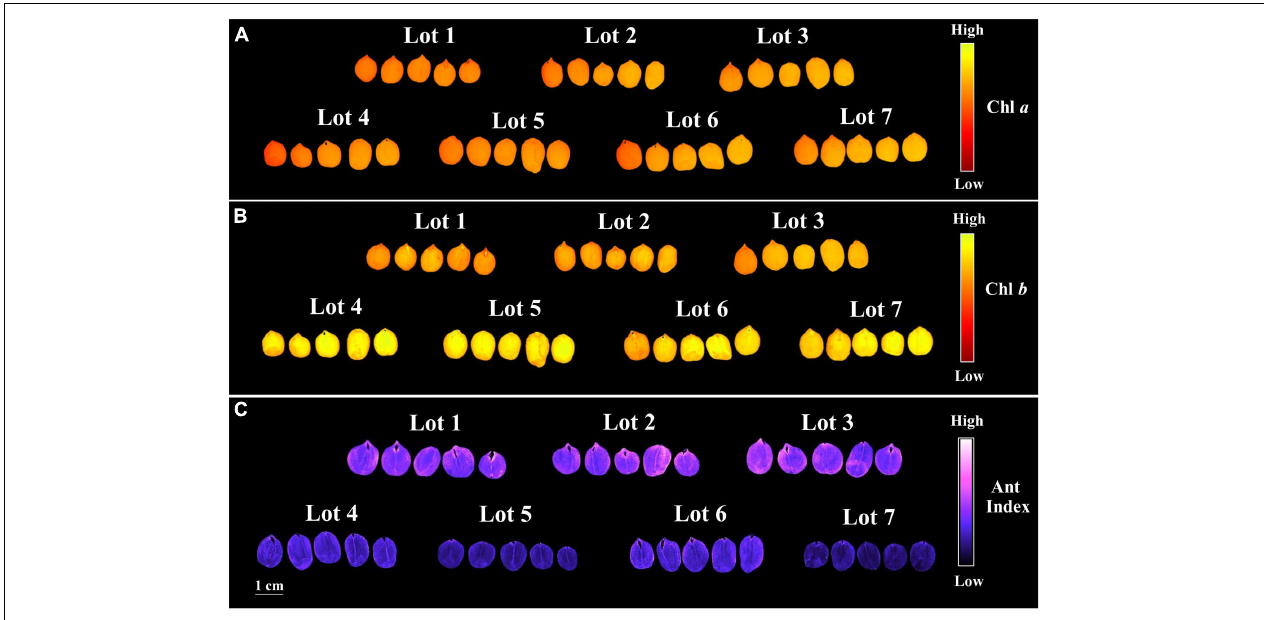
FIGURE 4 | Chlorophyll a fluorescence (Chl a ) at excitation/emission combination of 630/700 nm (A) , chlorophyll b fluorescence (Chl b ) at excitation/emission combination of 405/600 nm (B) , and anthocyanin index (Ant Index) (C) of seven seedlots of peanut seeds ( Arachis hypogaea L.; cv. IAC OL3). Each pixel in the images is represented by a unique value that corresponds to chlorophyll a and b fluorescence intensity or anthocyanin level.